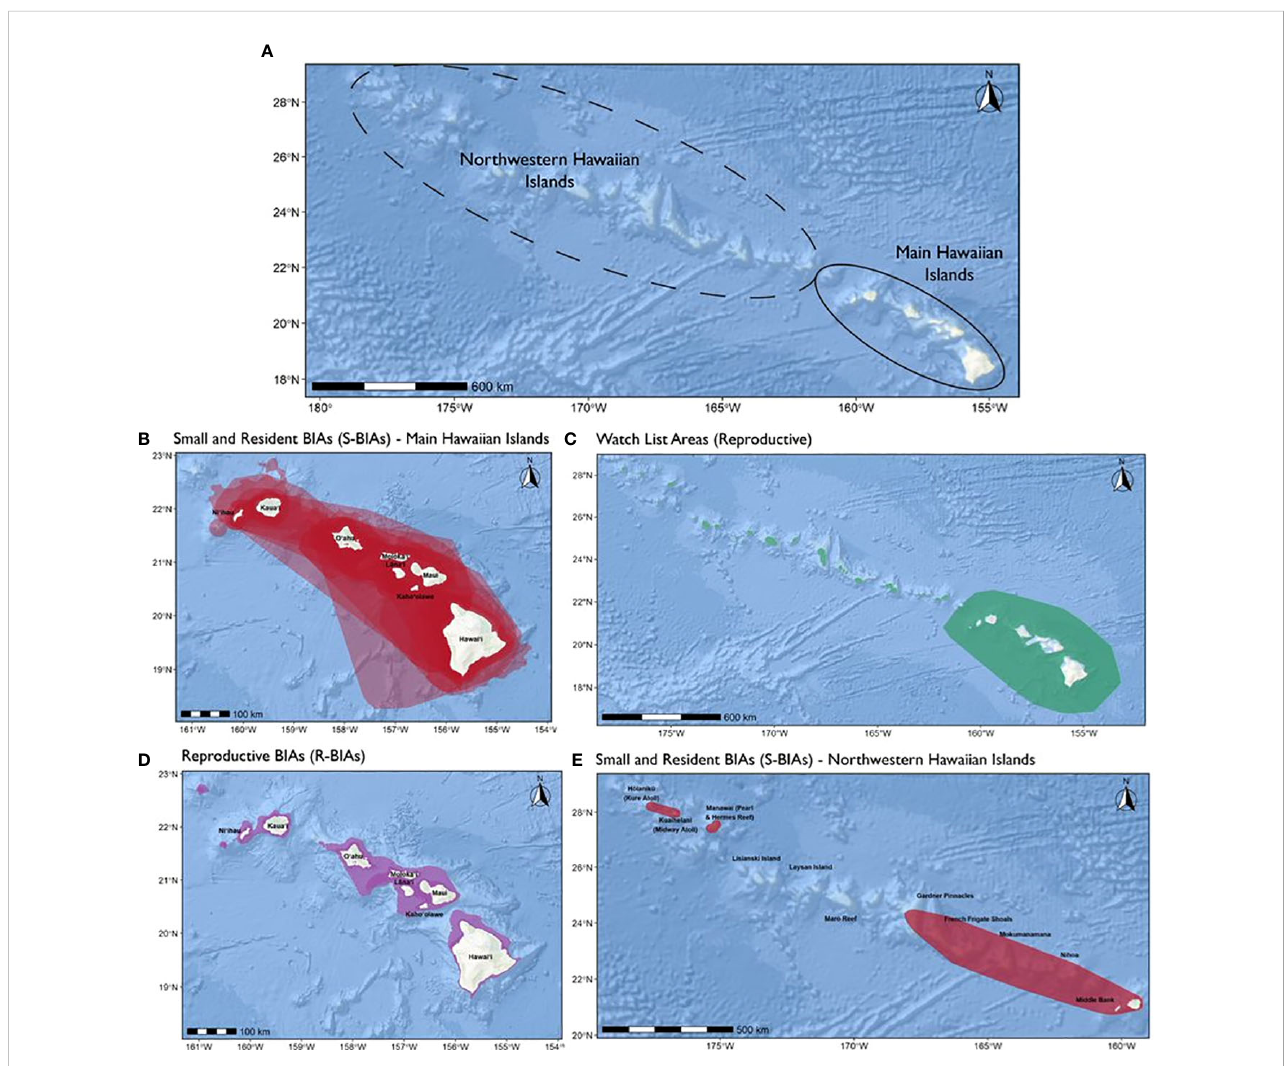
FIGURE 9 All Hawai ʻ i BIAs by BIA type and region: (A) Locality of the Main Hawaiian Islands and Northwestern Hawaiian Islands within the Hawaiian Archipelago; (B) S-BIAs in the Main Hawaiian Islands (n=30, darker red areas indicate higher overlap among BIAs); (C) watch list areas (n=2; reproductive; (D) R-BIAs in the Main Hawaiian Islands (n=2)); (E) S-BIAs in the Northwestern Hawaiian Islands (n=3). Basemap image is the intellectual property of Esri and is used herein with permission. Copyright © 2022 Esri and its licensors. All rights